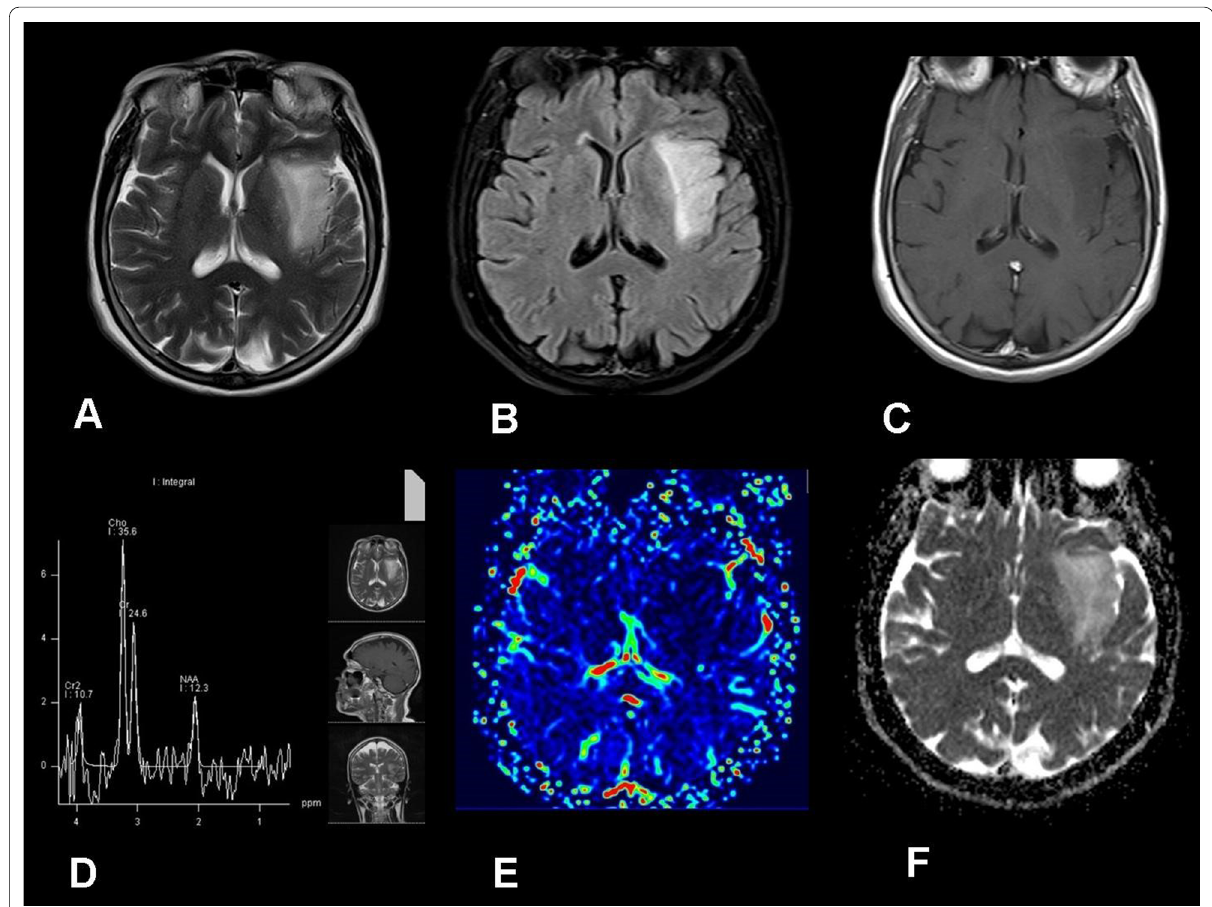
Fig. 3 66-year-old female with right sided weakness showing left parietal cortical and sub cortical lesion A , B , C axial T2, FLAIR, T1 GAD. The lesion showed T2 and FLAIR hyper intense signals with no enhancement after contrast administration. D Intermediate echo spectroscopy curve shows relatively high Cho levels and low Cr and NAA levels. E rCBV color perfusion map for the same lesion shows rCBV of 1.05 F ADC image shows